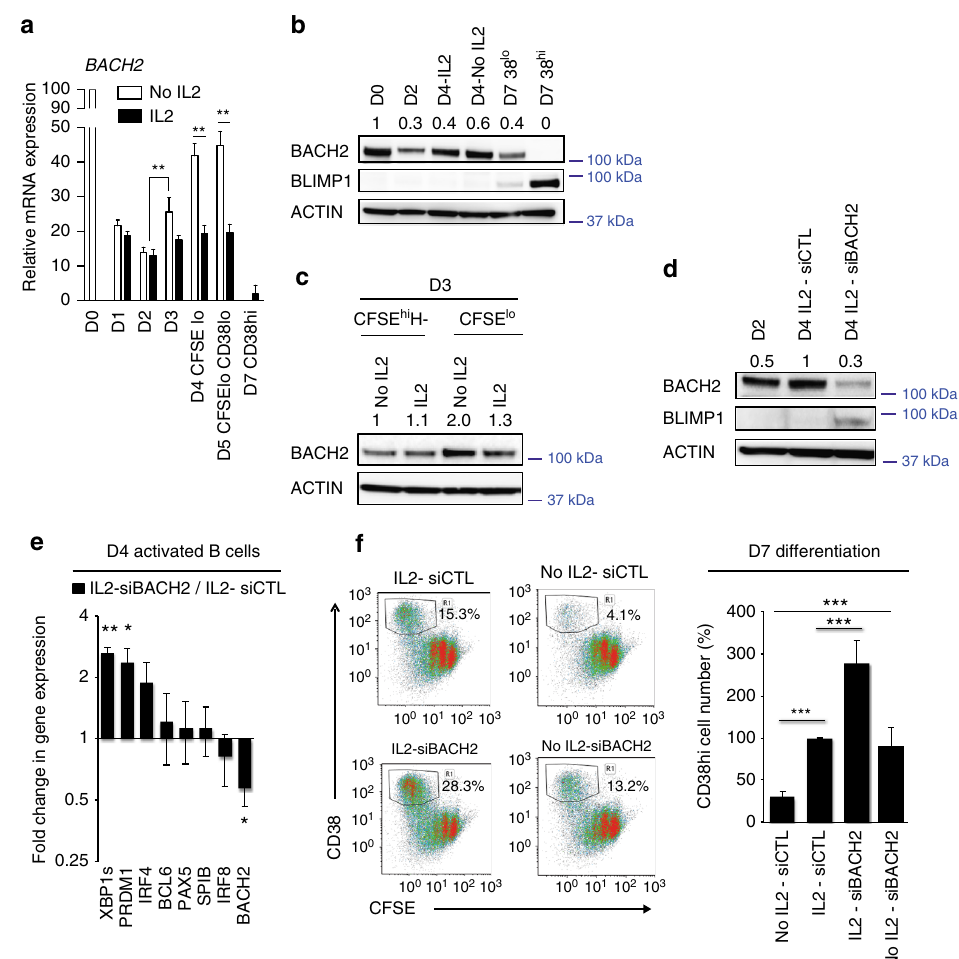
Fig. 2 Transient inhibition of BACH2 expression induces plasma cell differentiation. a Time course analysis (D0 − D7) of BACH2 expression quanti fi ed by QRT-PCR and normalised to HPRT1 during naive B cells differentiation in proliferative subsets (sorted CFSE lo cells) and differentiated plasma cells (CD38 hi ). Naive B cells were stimulated with IL-2 during the activation phase (black bars) or not (No IL2, white bars). Expression in naive B cells (D0) was fi xed to 100 and the experiments repeated on 6 different B cell donors. b Representative western blot for BACH2 and BLIMP1 protein levels at the indicated days of naive B cells culture. β -ACTIN was used as loading control. Values are the average fold changes in the expression levels of BACH2 normalised to β ACTIN for three independent experiments. c BACH2 protein levels in different subsets of D3-naive B cells stimulated or not with IL-2 for 24 h. Cells were sorted according to CFSE dilution and Hoechst (H) staining. CFSE hi H − corresponds to the non-proliferative subset. β -ACTIN served as loading control. This analysis was repeated two times. Values are the average fold changes in the expression levels of BACH2 normalised to β -ACTIN levels. d Protein expression levels of BACH2 and BLIMP1 analysed by immunoblotting, β -ACTIN was used as loading control. The ef fi ciency of BACH2 inhibition with siRNA (siBACH2) was monitored at D4, 48 h after cell electroporation. Non-targeting siRNA (siCTL) was used as control. Values are the average fold changes in the expression levels of BACH2 normalised to β -ACTIN levels for four independent experiments. e Fold change in gene expression levels analysed by QRT-PCR in D4-IL-2-primed cells that were electroporated on D2 with siBACH2. Expression levels of three independent experiments were normalised to expression levels in the control cells (IL2-siCTL). f Flow cytometry analysis of CD38 hi CFSE lo plasmablasts generated at D7 following IL-2 priming (IL2) or in absence of IL-2 priming (No IL2) and electroporated with siBACH2 or siCTL at D2. The absolute numbers of plasmablasts were quanti fi ed by fl ow cytometry for seven independent experiments. Results were normalised to the IL2-siCTL condition arbitrary fi xed to 100 for all the experiments. Values in a , e , f are shown as means ± s.e.m., * p < 0.05, ** p < 0.01, *** p < 0.005, NS: No signi fi cant differences, Mann − Whitney test was used for a and f , two-tailed unpaired Student ’ s t -test for e protein level (Fig. 2b, c) and raised the possibility that BACH2 upregulated ( p < 0.05, t -test) whereas the expression of the B cell- may control the engagement of B cells in the differentiation path. speci fi c transcription factors BCL6 , PAX5 , SPIB and IRF8 did not To test this hypothesis, we used small interfering RNAs show any signi fi cant difference compared with the control IL-2- (siBACH2) to transiently inhibit BACH2 expression at D2 primed cells at D4, suggesting that BACH2 targets primarily the through to D4. Knockdown ef fi ciency was controlled by immu- plasma cell transcriptional program (Fig. 2e). We next explored noblotting 2 days after electroporation (Fig. 2d, Supplementary plasma cell differentiation by fl ow cytometry at D7 (Fig. 2f). Fig. 2a). Consistent with the known regulation of PRDM1 by BACH2 inhibition signi fi cantly increased the capacity of IL-2- BACH2, an unimpeded BLIMP1 expression was observed in primed cells to differentiate ( p < 0.005, Mann − Whitney test). BACH2 de fi cient cells. At the mRNA level the expression of the More importantly, BACH2 inhibition was suf fi cient to drive plasma cell-speci fi c transcription factors PRDM1 and XBP1s was differentiation in the absence of IL-2. NATURE COMMUNICATIONS | 8: 1443 | DOI: 10.1038/s41467-017-01475-7 |